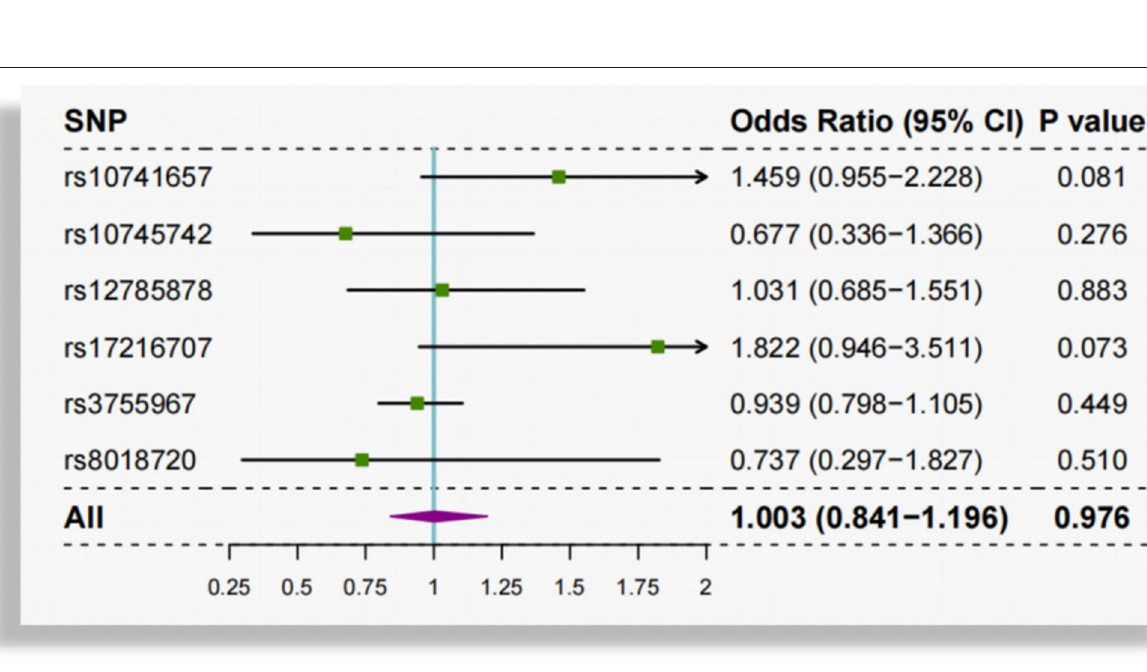
FIGURE 2 | Mendelian randomization estimates of the association between genetically predicted circulating vitamin D and atrial fibrillation. CI, confidence interval; IVW, inverse-variance-weighted.